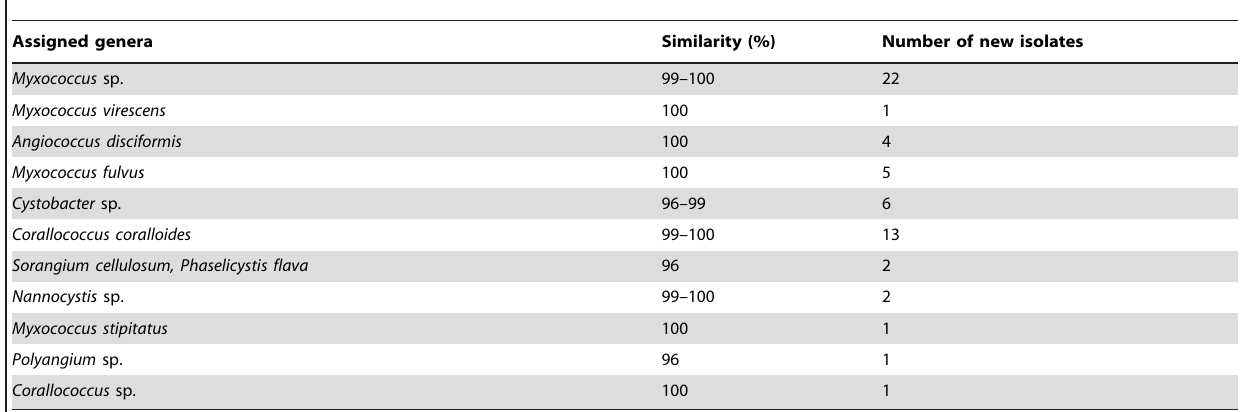
Table 4. Identities of new myxobacterial isolates based on 16S r DNA analysis.